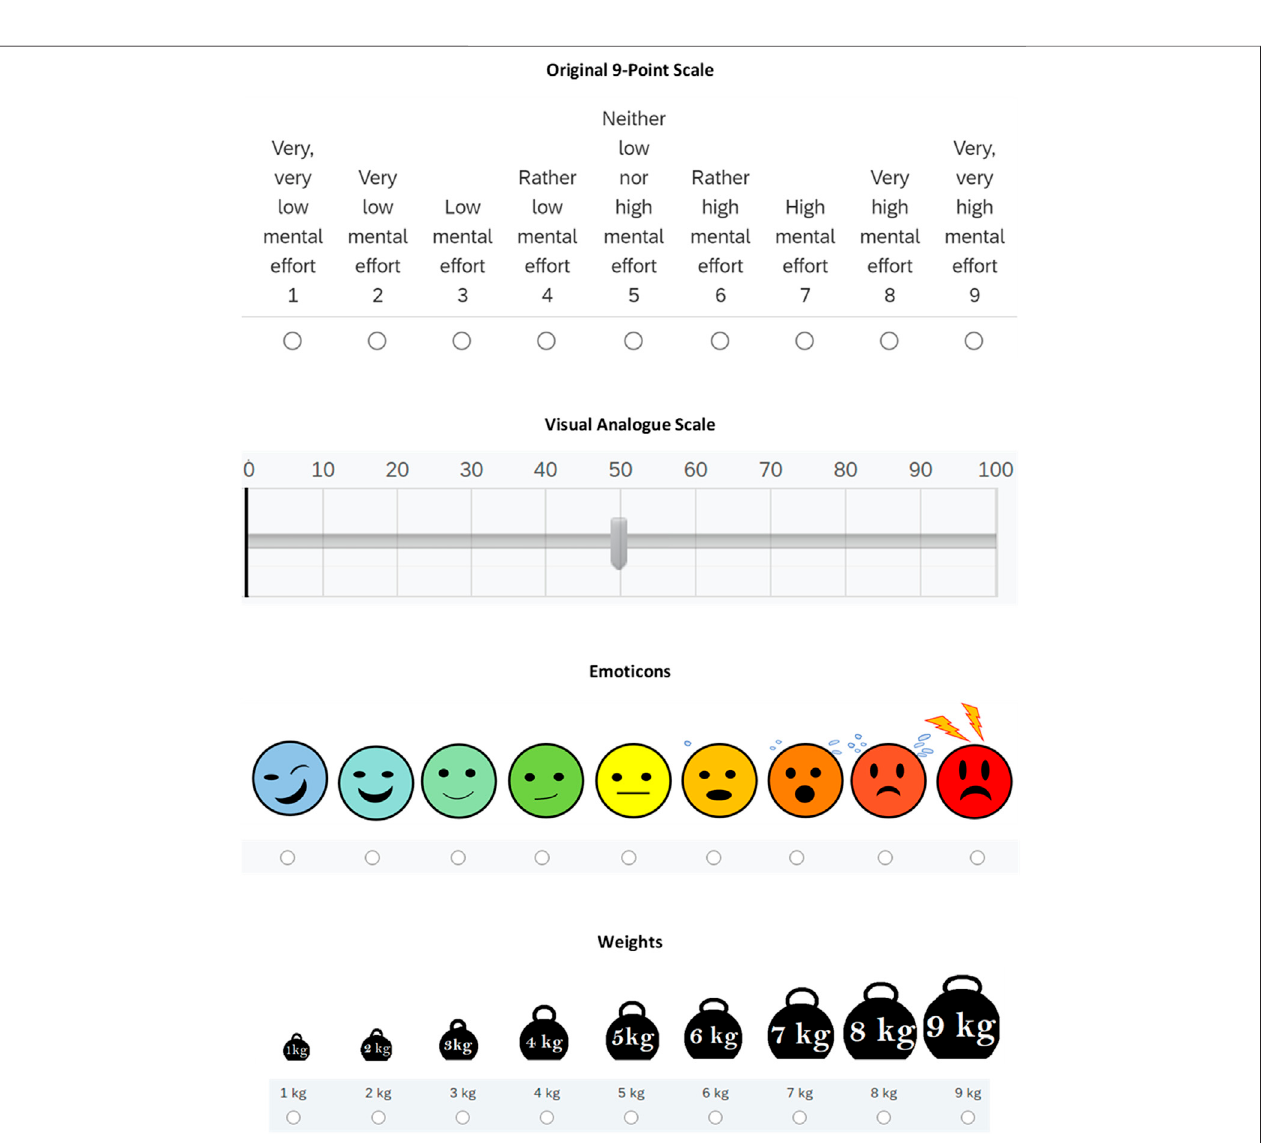
FIGURE 1 | Subjective Rating Scale Types used in the Present